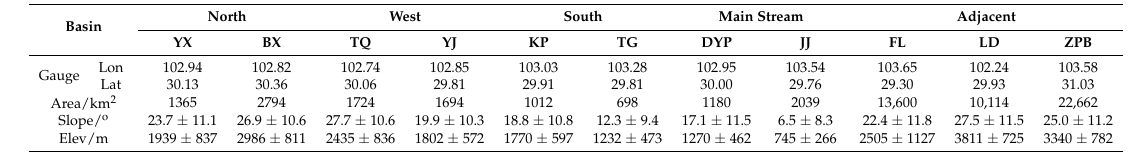
Table 1. The hydrological gauges in the QYJ and adjacent basins. For simplicity, the gauge names are used to denote related basins.